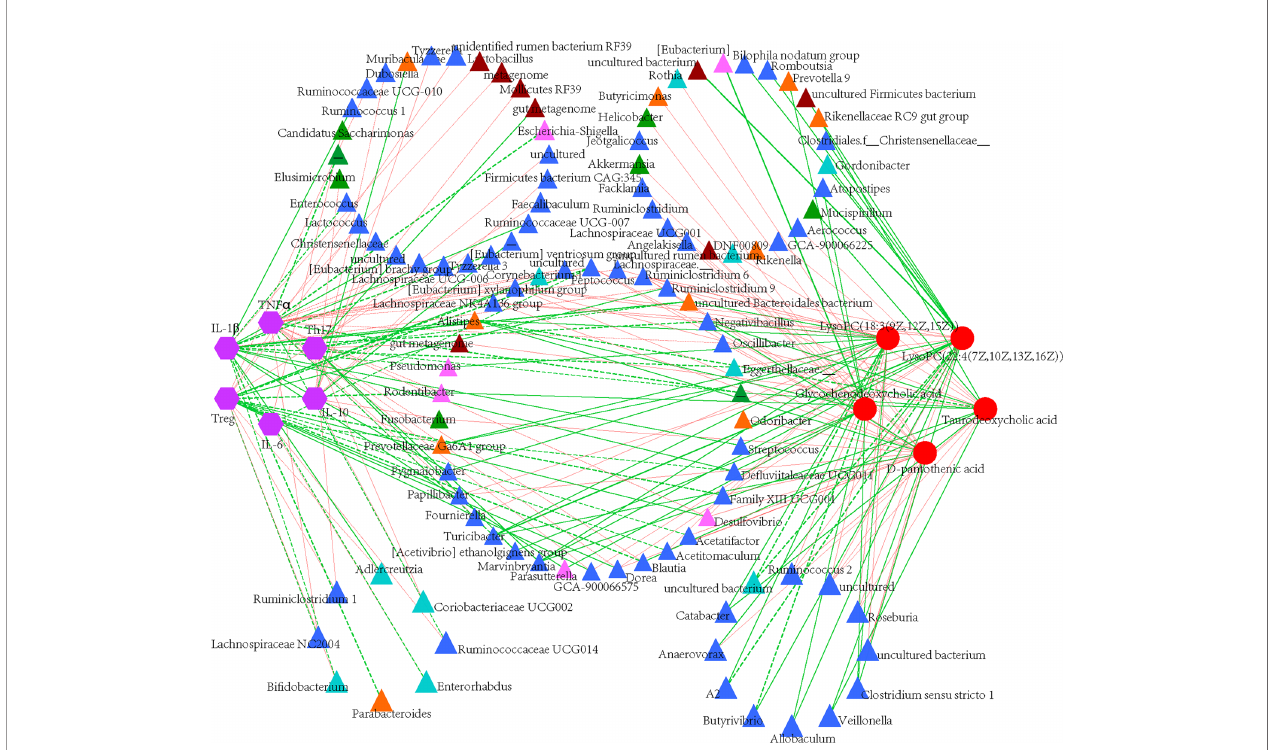
FIGURE 9 | Construction of correlation-network diagram. Correlation analyze of gut microbial genus (relative abundance > 0.1%), cytokines and identi fi ed differential metabolites that involved in pathway analyzes. The edge colors indicate positive (red) or negative (green) correlations. Thickness of edge represents correlations and the color indicate positive (green) and negative (red) correlations, and dotted line indicated signi fi cant correlations.